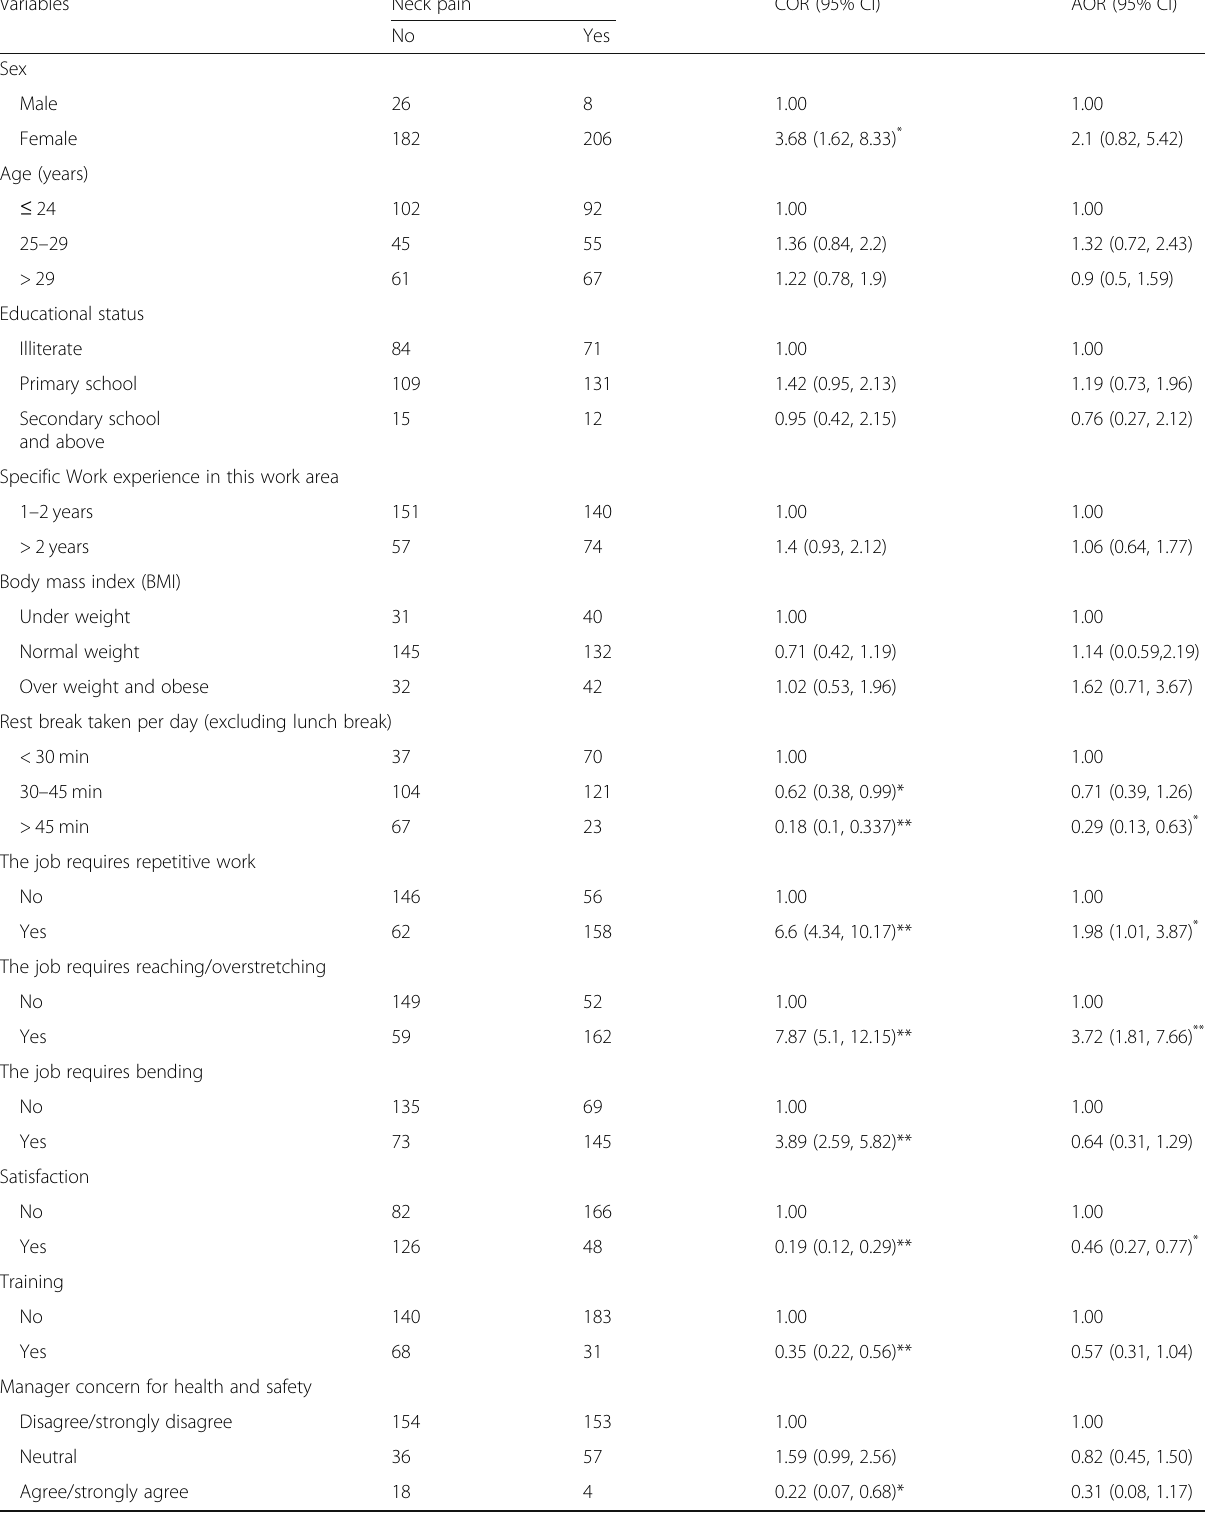
Table 3 Bivariate and multivariable binary logistic regression analysis of factors associated with neck trouble among hotel housekeepers, Northwest Ethiopia, 2017 ( n =